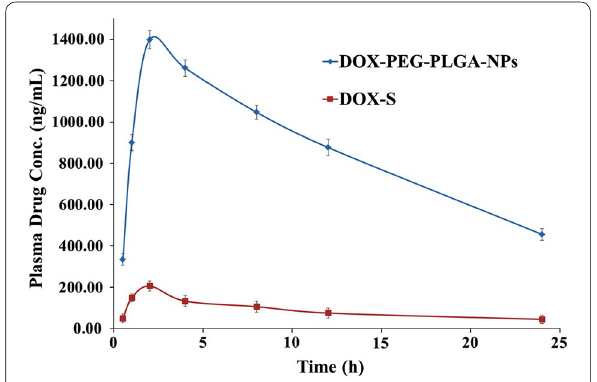
Fig. 8 Plasma drug concentrations verses time profiles of DOX in male wistar rats after 10 mg/kg single dose of DOX-S (oral) and DOX- loaded-PEG-PLGA-NPs